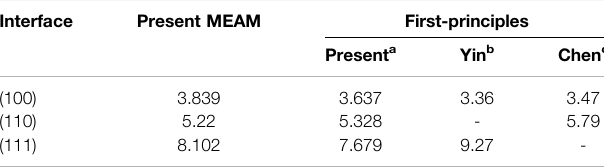
TABLE 7 | The adhesion energies of the TiN/CrN interface calculated by the present ternary potential, comparing with the fi rst-principles calculation values. The unit of the adhesion energy is J/m 2